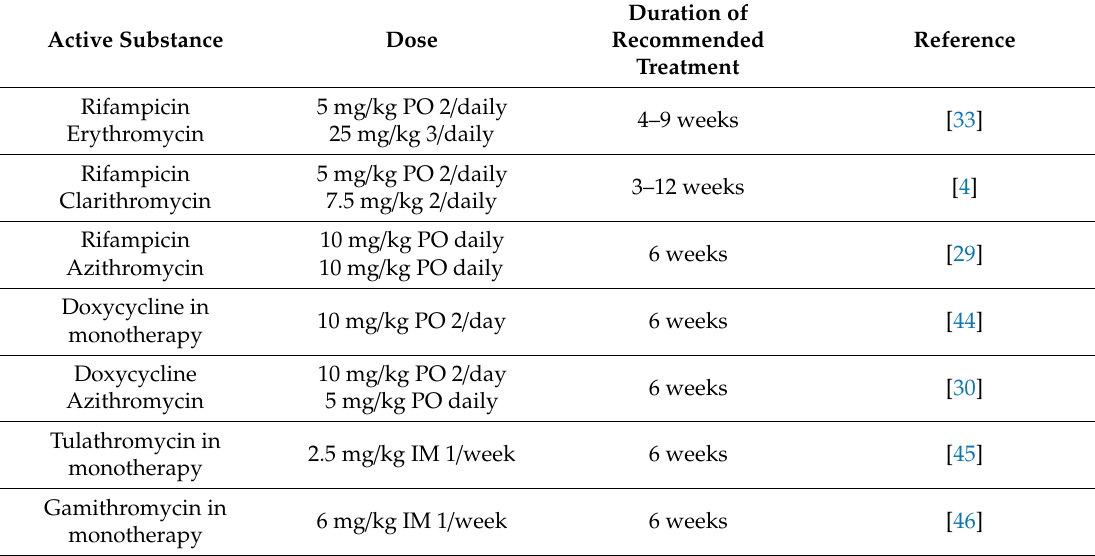
Table 1. Antibiotics recommended in equine